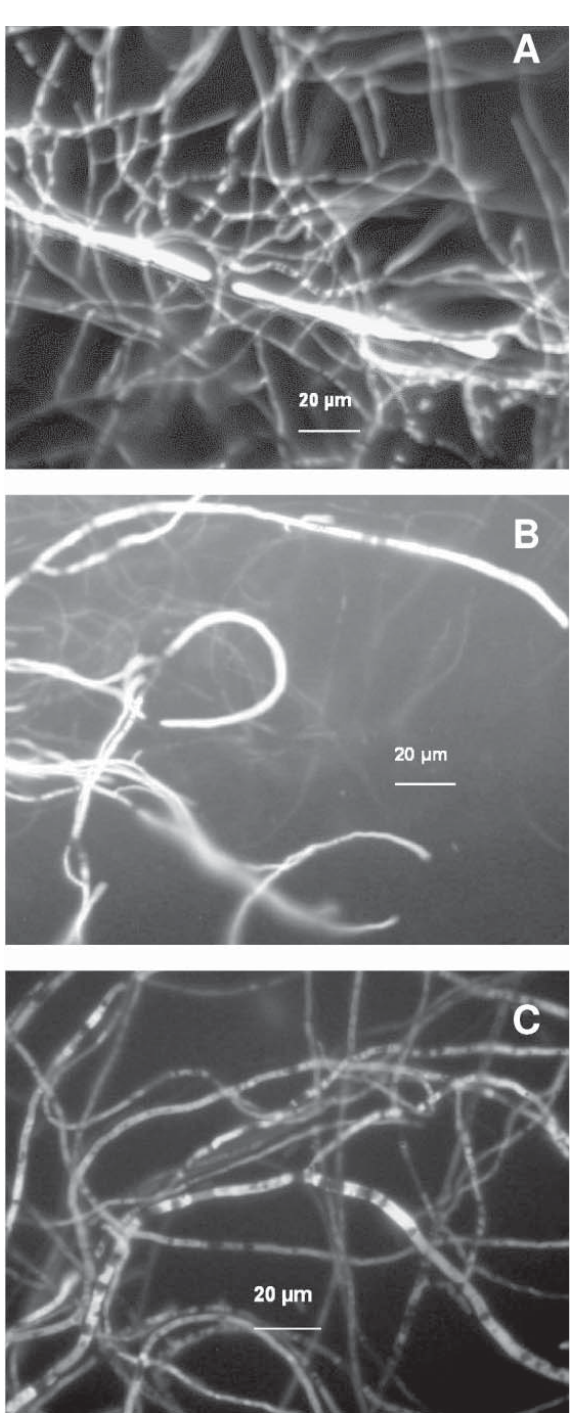
Fig. 4. Green fluorescent protein fluorescence of hyphae of pCT74 transformants of Eutypa lata S6 (A), and of Phaeomoniella chlamydospora P7 showing actively grow- ing hyphal tips (B) and older vacuolated hyphae